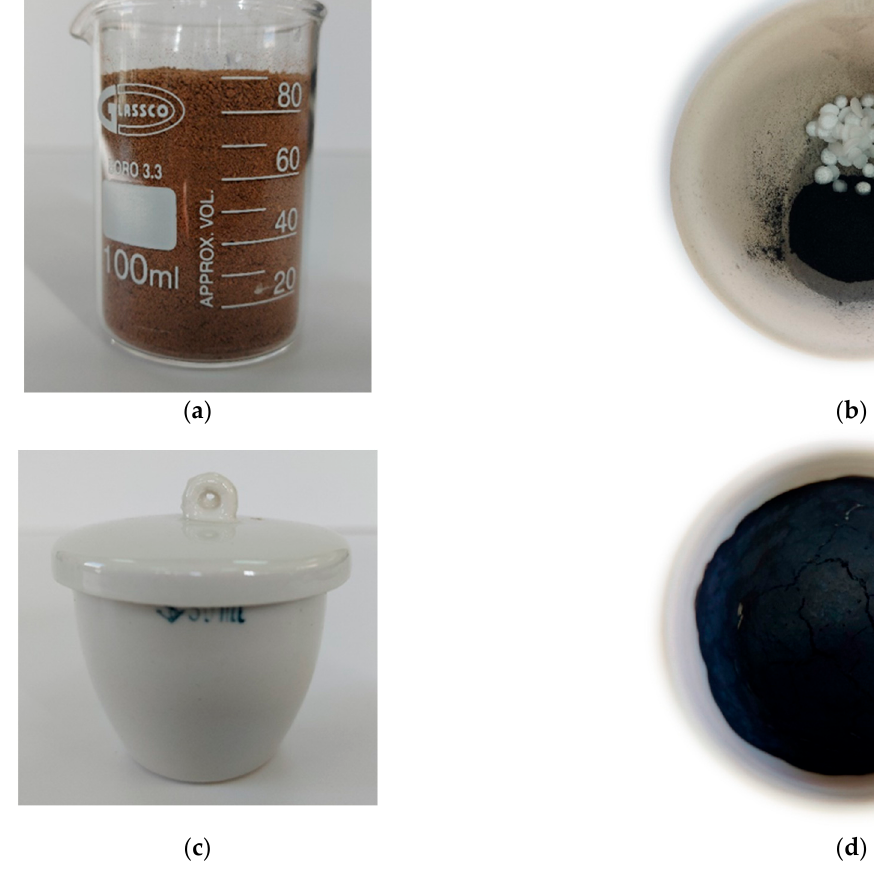
Figure 3. Procedure of generating activated carbons from WTLs: ( a ) purifying and crushing WTLs, ( b ) mixing and grinding WTLs with KOH, ( c ) carbonizing WTLs–KOH mixture at 600 °C, ( d ) the resulting activated carbons.